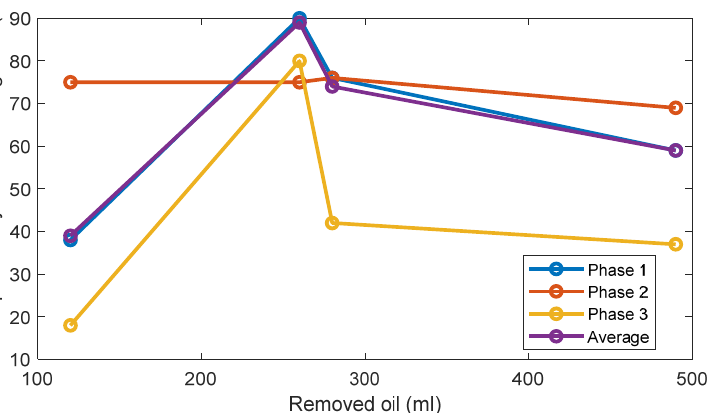
Figure 6. The TPOCD, provided by technology 1 (the third harmonic of the supply frequency), for three phases and 4 levels of oil removal compared to the standard oil level (Day 1).